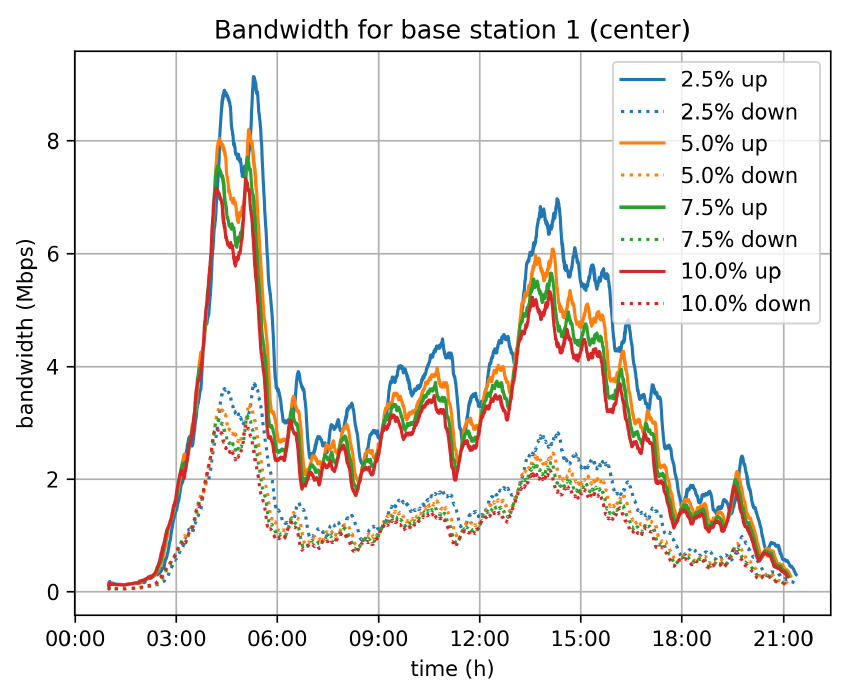
Figure 12. City center base station bandwidth